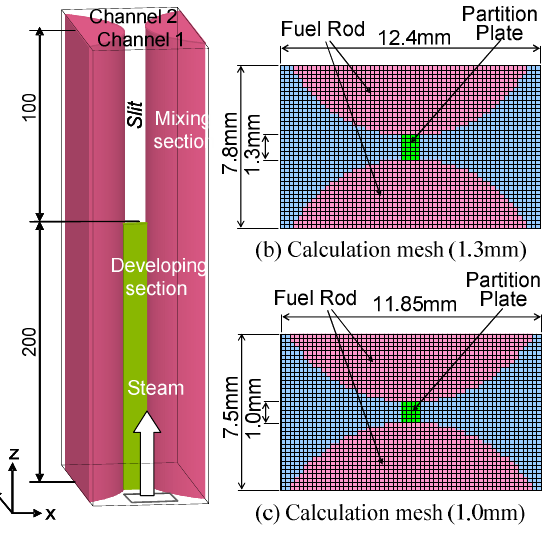
Fig.7 Dimensions of calculated test channel and